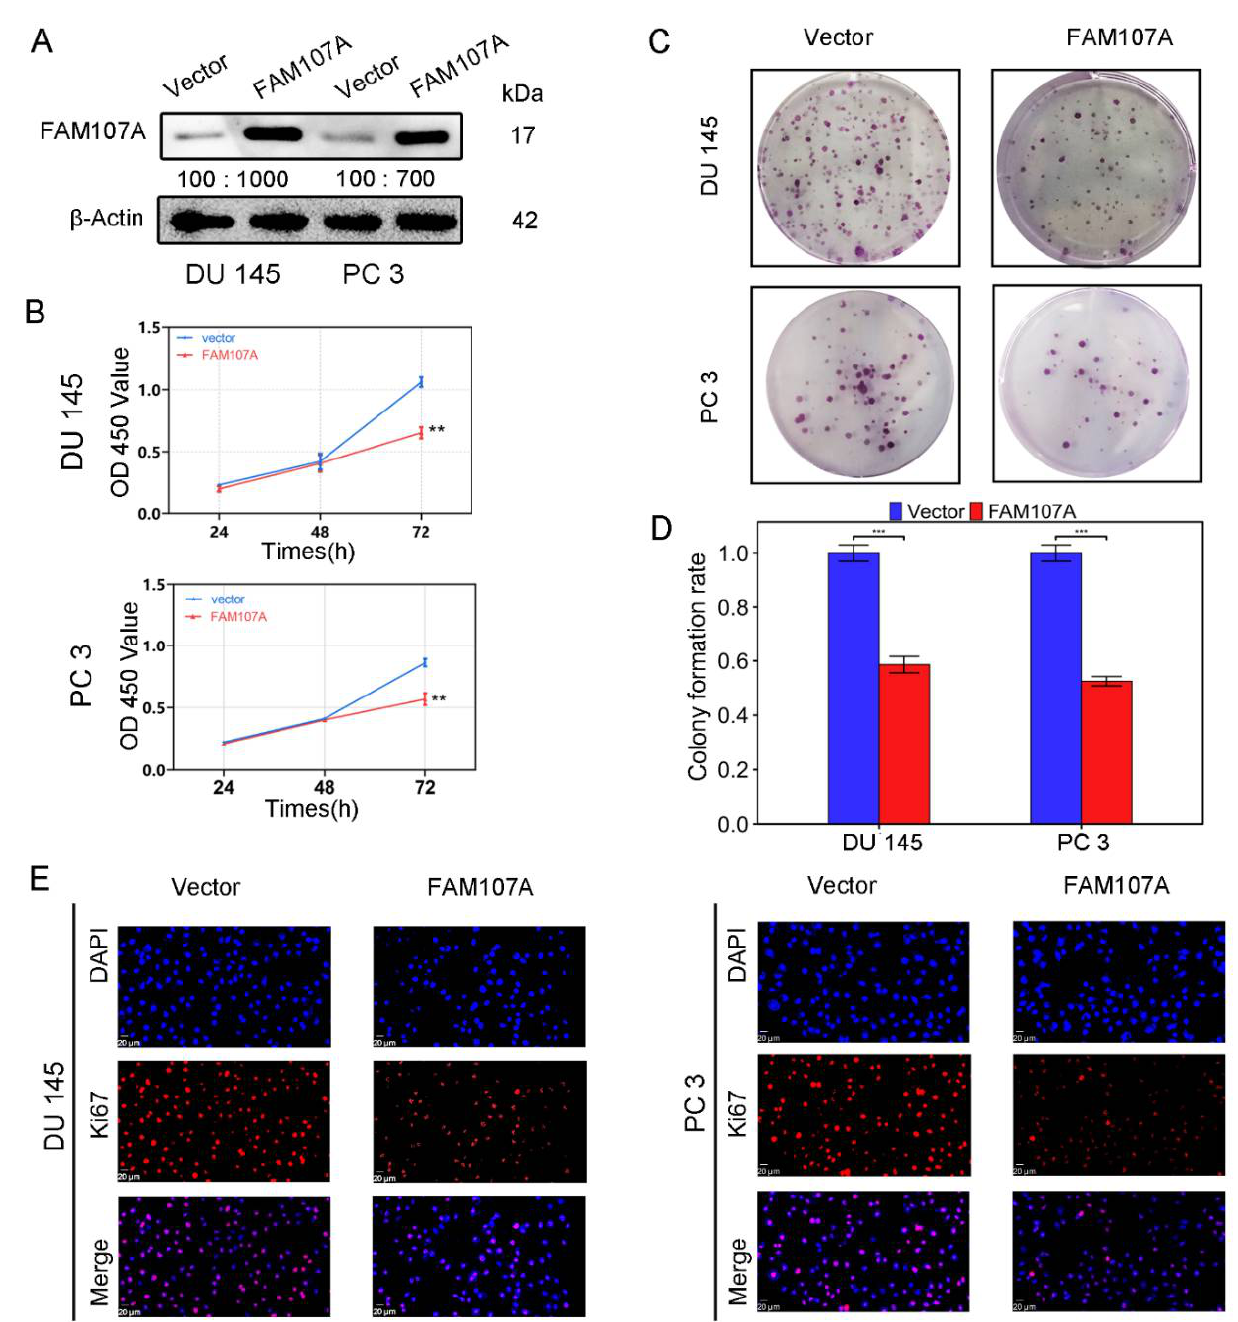
Figure 4. FAM107A overexpression inhibited the proliferation of PCa cells in vitro. ( A ) The Western blotting analysis confirmed the effect of FAM107A overexpression. The unit of molecular weight is kDa. ( B ) Comparison of the proliferative capacity of the two groups of cells, detected using the CCK-8 kit, with OD values measured every 24 h. ( C , D ) Comparison of the colony-forming ability of the two groups of cells. Colony formation was quantified 14 days after colony formation using ImageJ software. ( E ) Immunofluorescence was used to detect Ki67 expression in the cells at a magnification of 400 × . Similar results were obtained, and data are expressed as the mean ± SD of at least three experiments. *** for p < 0.001, and ** for p <